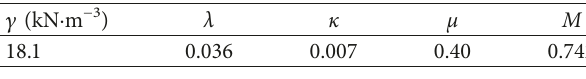
Figure 7: Pile shaft stress along with